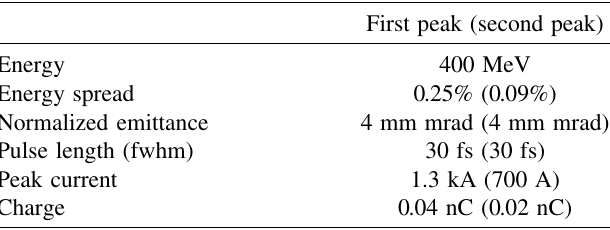
TABLE II. Beam parameters of the compressed electron bunch just before entering the FEL undulators.